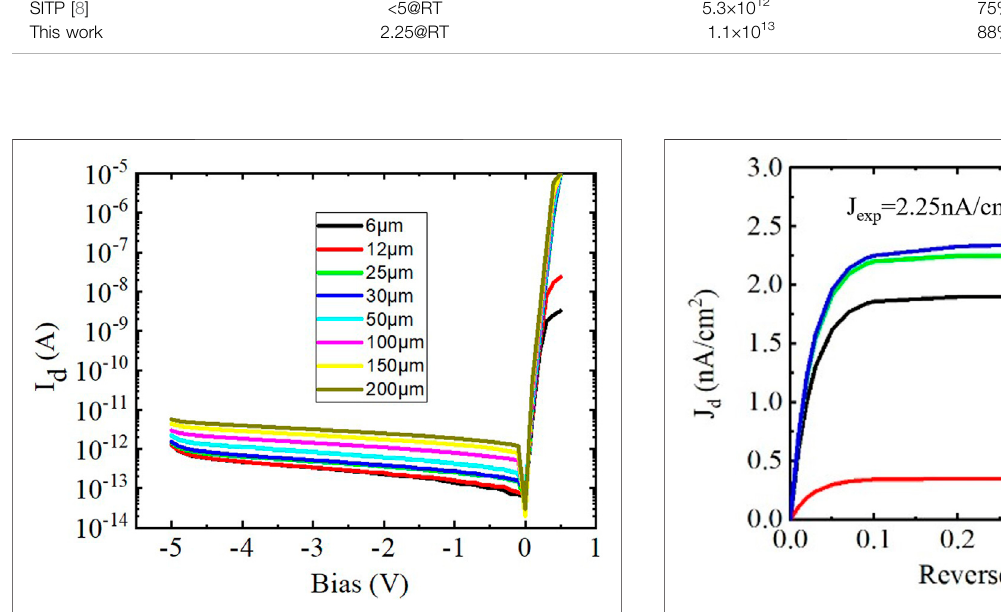
FIGURE 8 | Dark current versus bias. FIGURE 9 | Dark current density versus reverse bias.